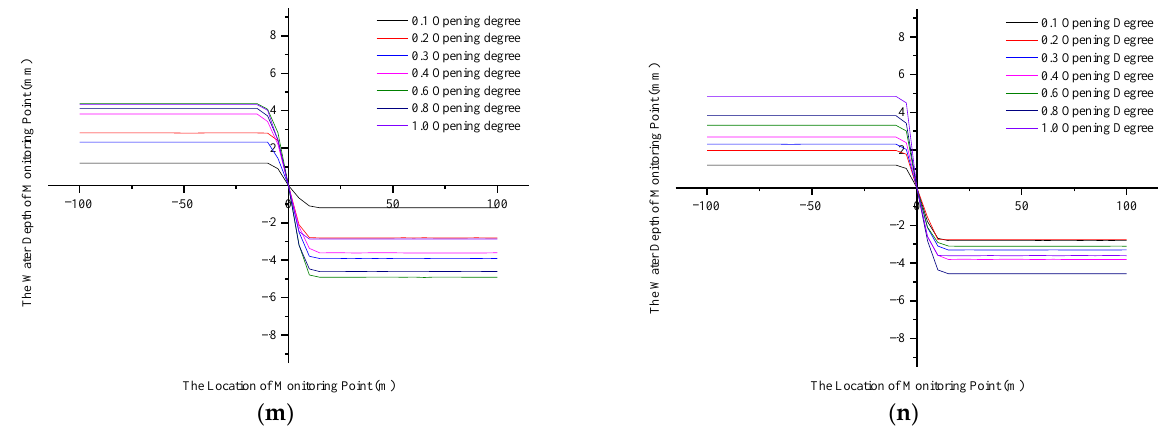
Figure 7. Numerical water-surface curves of the 14 branch channels: ( a – n ) the relationship between the 1st to 17th branches ′ water-surface and monitoring points under the conditions of opening degrees of 0.1, 0.2, 0.3, 0.4, 0.6, 0.8, and 1.0. X represents the distance between the monitoring point and the sluice position; Y represents the difference between the water depth of the monitoring point and the water depth of the sluice.